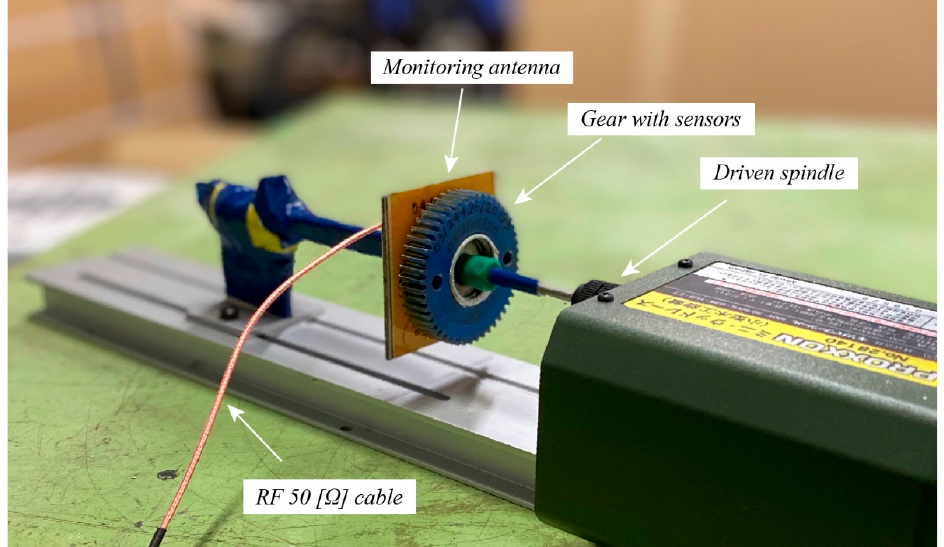
Figure 9. The self-configured device and setting for the experiment of phase fluctuation effect at high speed. Originally, this is a mini lathing machine by Proxxon.